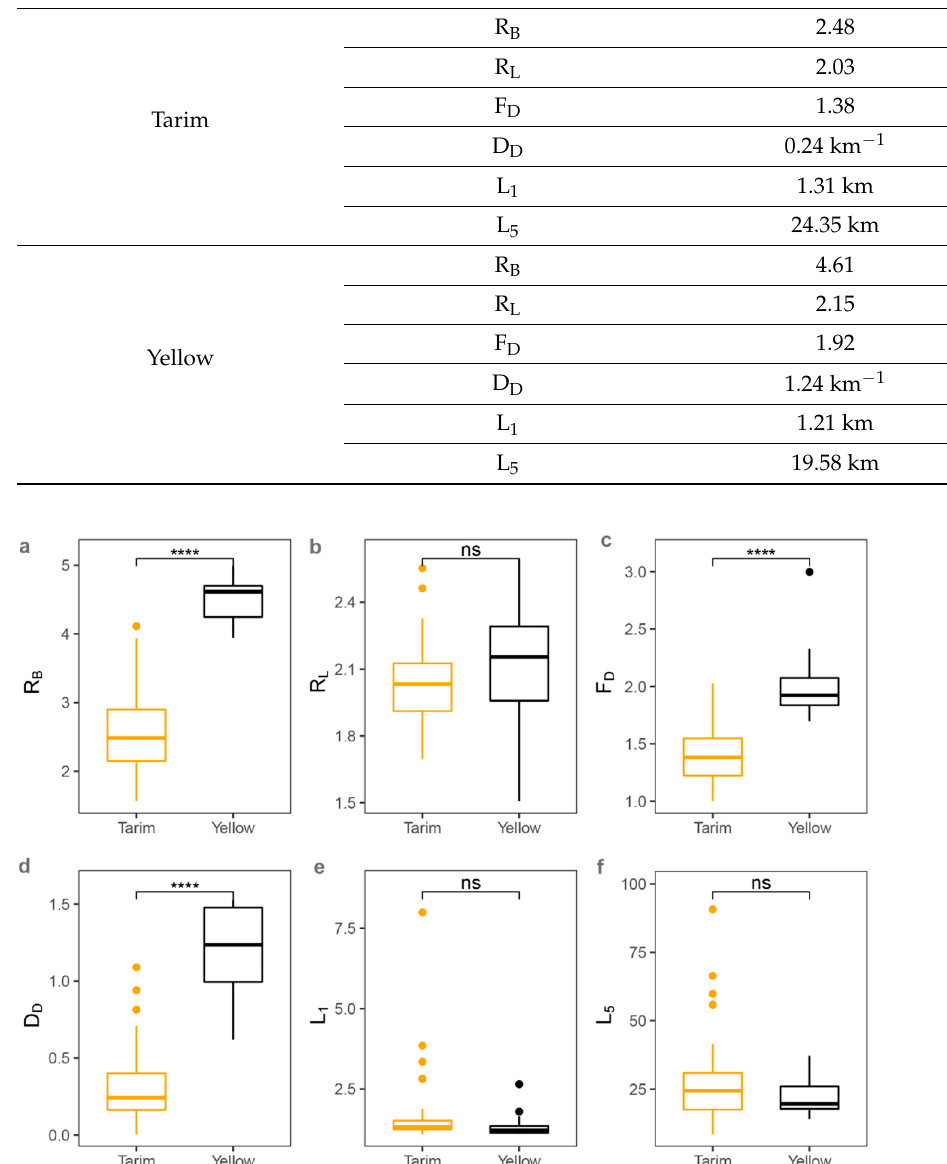
Table 2. Structural parameters of river networks in the Tarim and the Yellow River basins.